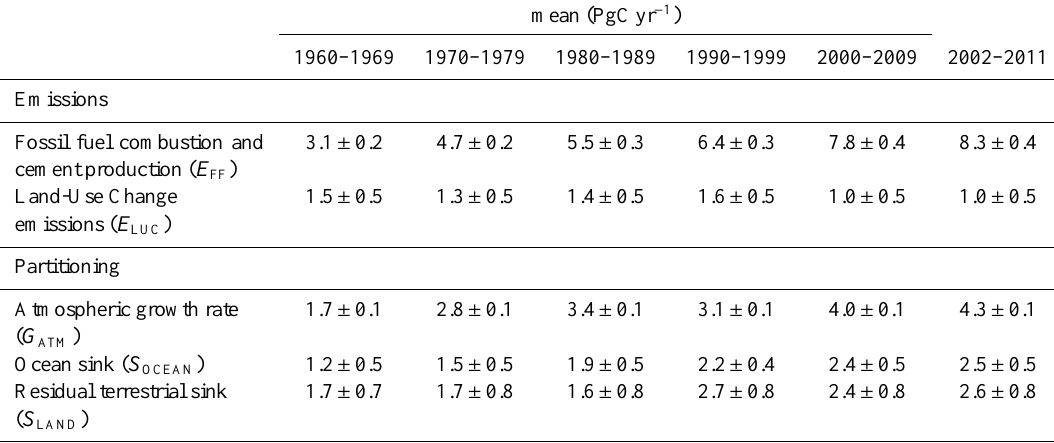
Table 4. Decadal mean in the five components of the anthropogenic CO 2 budget for the periods 1960–1969, 1970–1979, 1980–1989, 1990– 1999, 2000–2009 and the last decade available. All values are in PgCyr − 1 . All uncertainties are reported as ± 1 sigma (68% confidence assuming Gaussian error distributions that the real value lies within the given